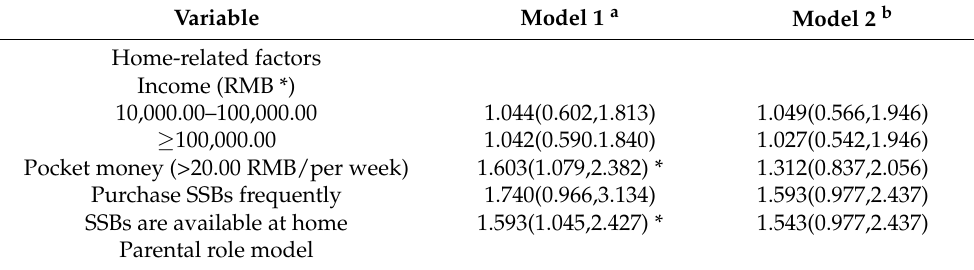
Table 5. Factors associated with sugar-sweetened beverage intake in normal weight